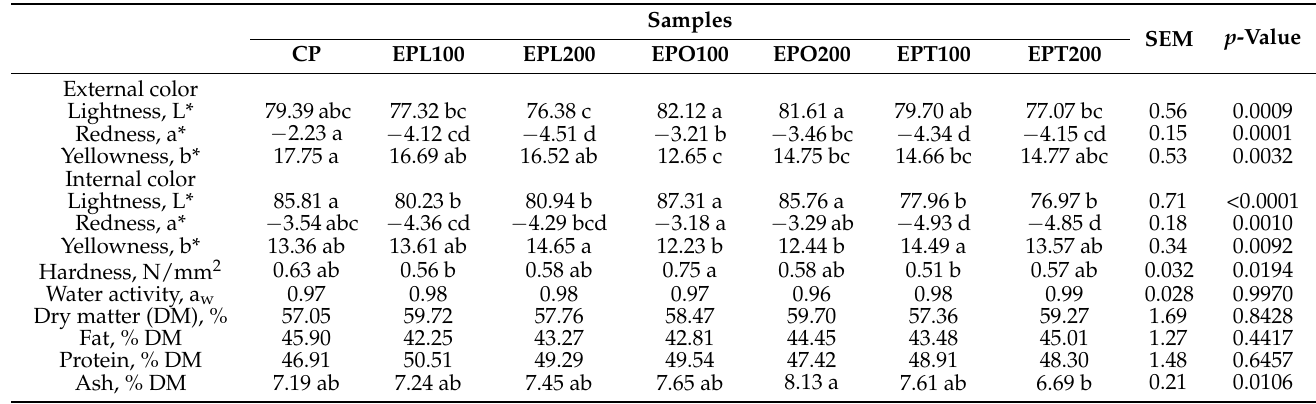
Table 3. Physicochemical traits of Primosale